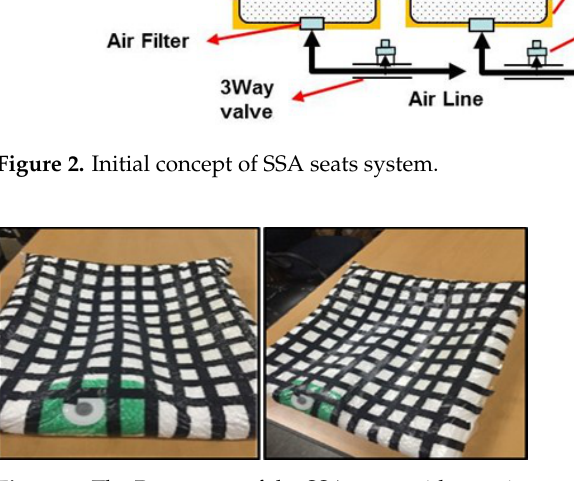
Figure 3. The Proto type of the SSA seats with a grain type. Front ( left ), Diagonal ( right